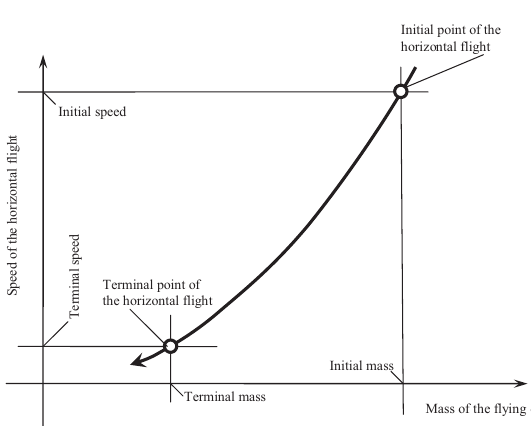
Figure 1. Infographic diagram and the related